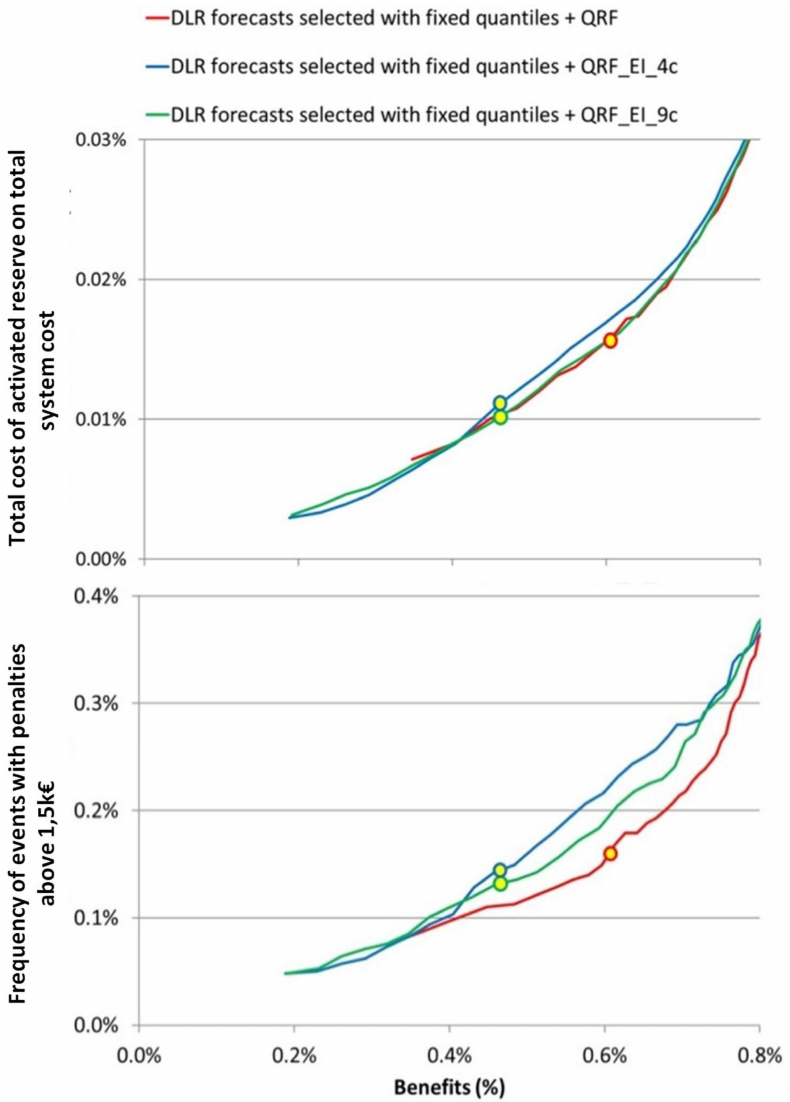
Figure 5. Evolution of total reserve costs and frequency of incidents depending on the observed benefits. Fixed quantiles are employed, and depending on the forecasts, the situations associated with the use of 1% quantile forecasts are represented by